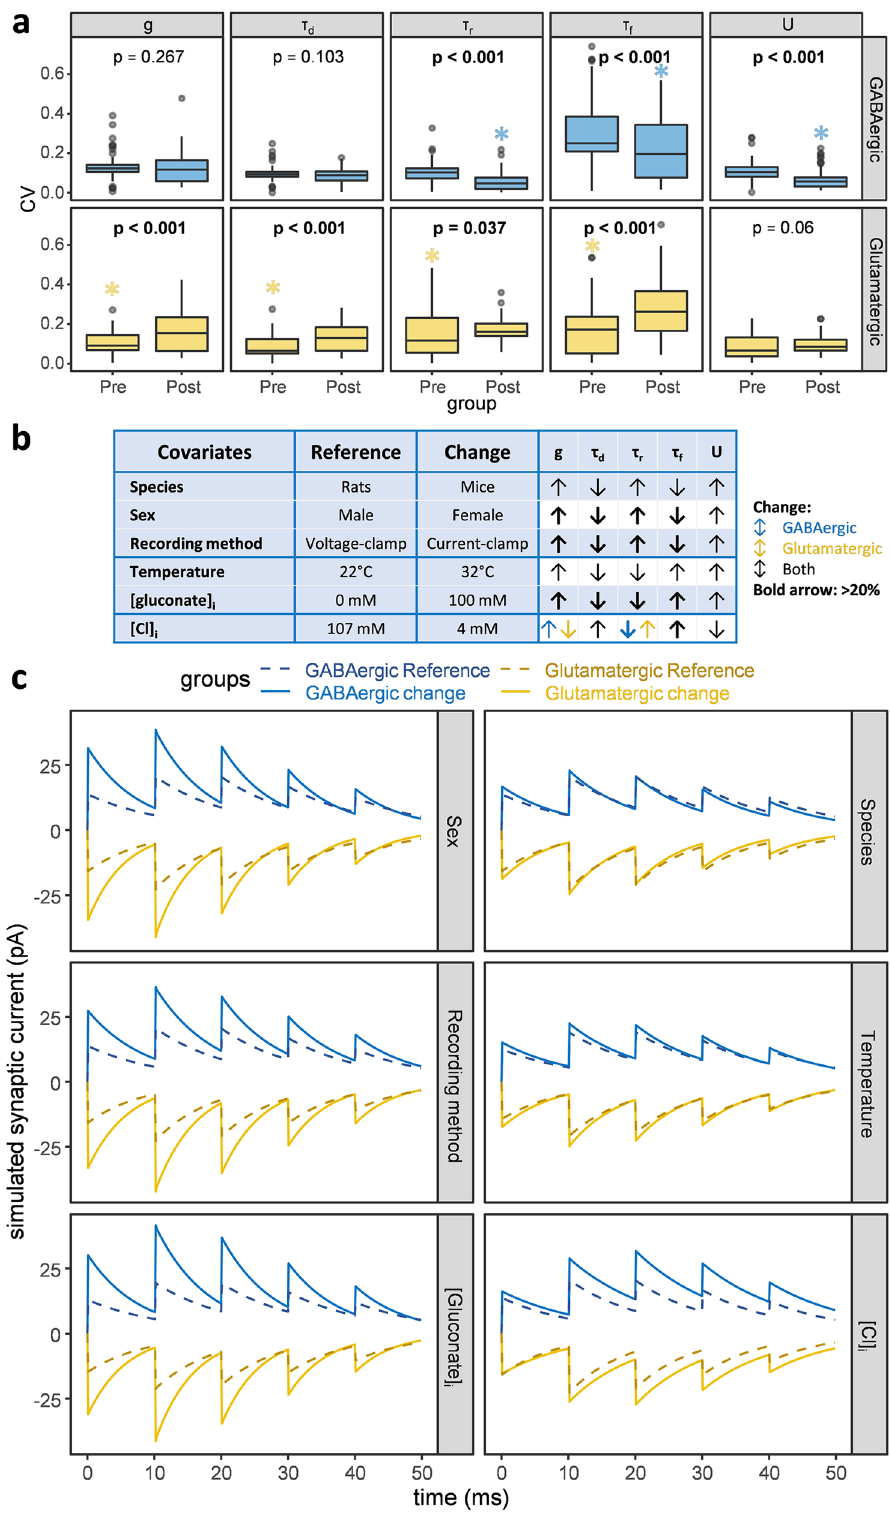
τ τ d and f among GABAergic synapses in CA3, and in and CA2. Glutamatergic synapses generally demonstrated fewer signi fi cant differences. Visualizing consensus traces (Suppl. Fig- ure 7b) and synaptometrics differences (Suppl. Fig. 7c) con fi rmed these patterns. In the visual cortex, connection probability correlates with synaptic strength 32 . Hippocampome.org calculates the